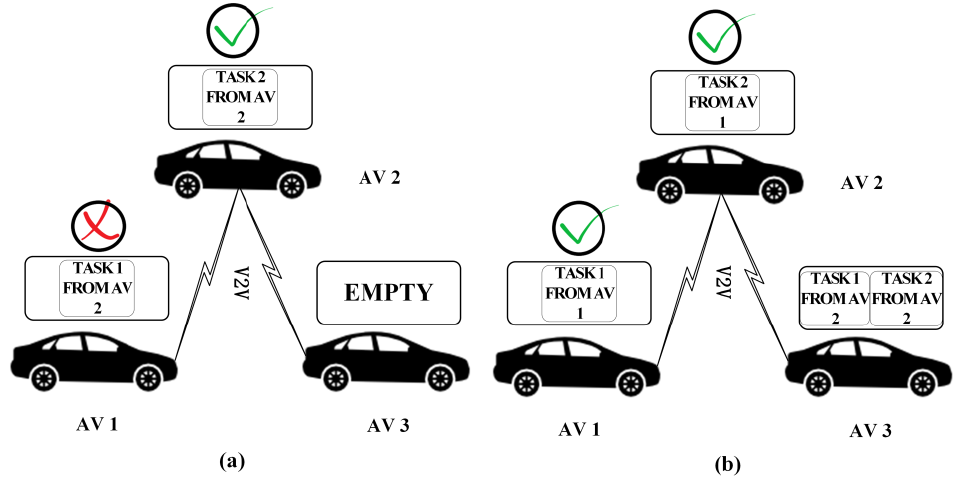
Figure 4. Example: impacts of NoN on the number of AVs whose tasks can be completed. ( a ) Vehicle with more NoN offloads first; ( b ) otherwise.